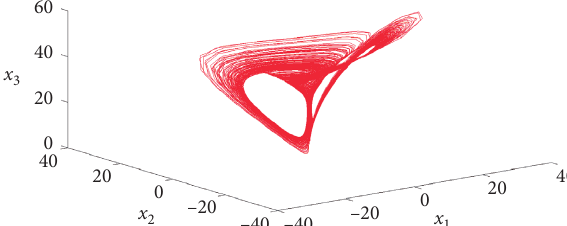
Figure 6: The trajectory of the states of system (34) with the coefficients a � 35, b � ( 8/3 ) , and c � 25 and the initial condition x ( 0 ) � ( 3 , 4 , 5 ) T .